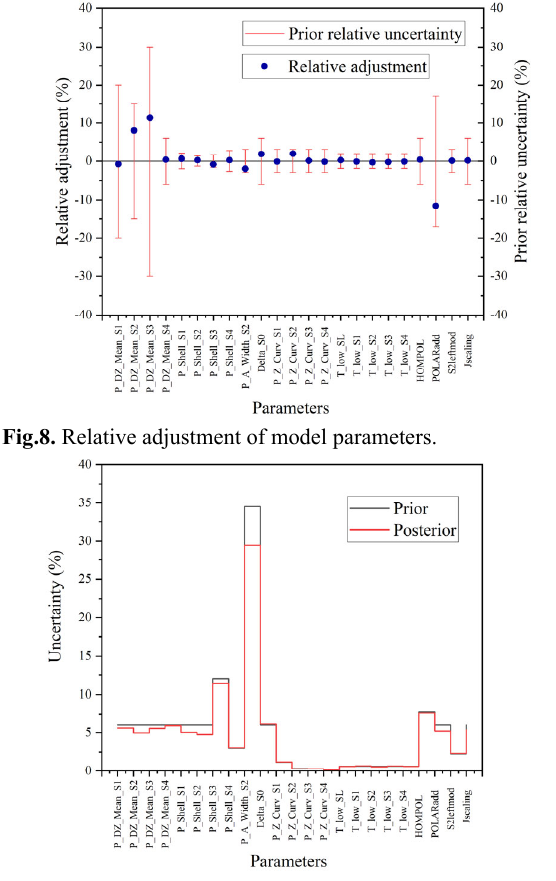
Fig.9. Comparison of uncertainties of prior and posterior